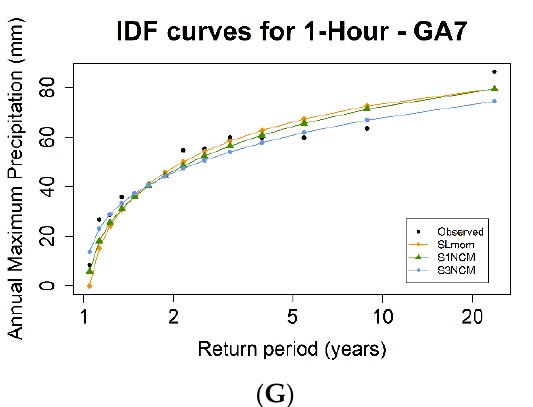
Figure 8. Estimated IDF curves using three temporal downscaling approaches. The 1-h IDF curves for Almagosa ( A ), Fena Lake ( B ), Geomag ( C ), Mt. Chachao ( D ), Mt. Santa Rosa ( E ), Umatac ( F ), and Windward Hills ( G ), respectively.